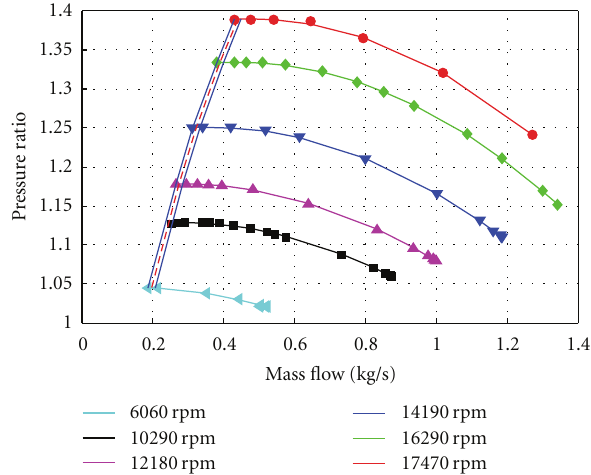
Figure 8: Multispeed characteristic curves of test rig (0.6 mm (23mils) tip clearance, inlet pressure = 1.012 bar, inlet temp. = 22 C, humidity = 24%).